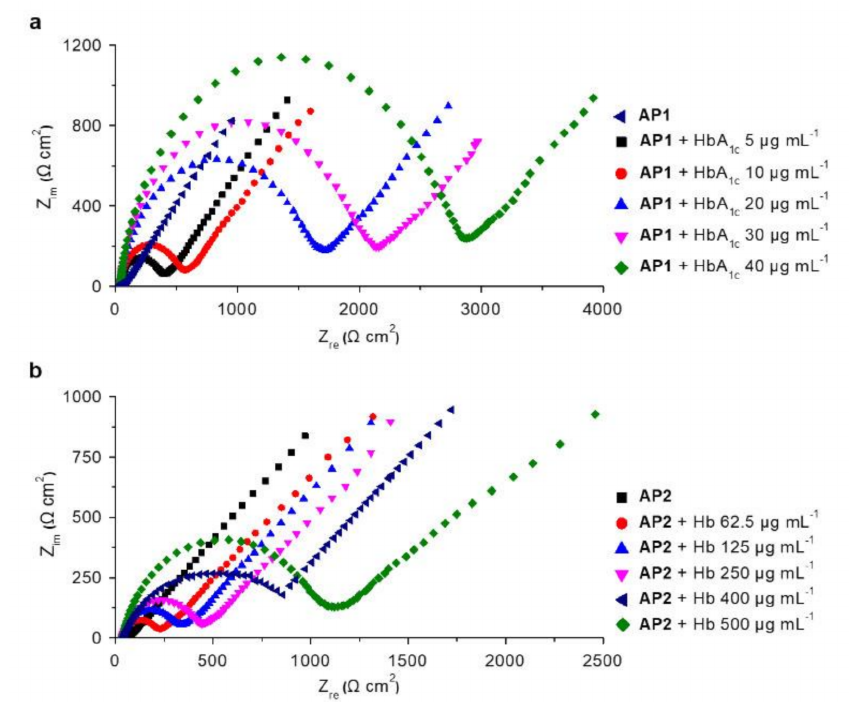
Figure 2. Impedimetric changes of ( a ) aptasensor 1 ( AP1 ) with increasing HbA 1c and ( b ) aptasensor 2 ( AP2 ) with increasing Hb measured by AC impedance